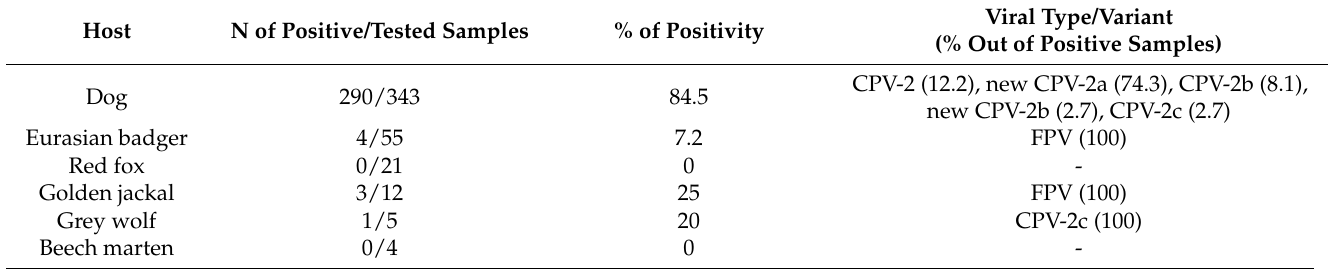
Table 3. Details of samples including the genetic and antigenic characterization of positive